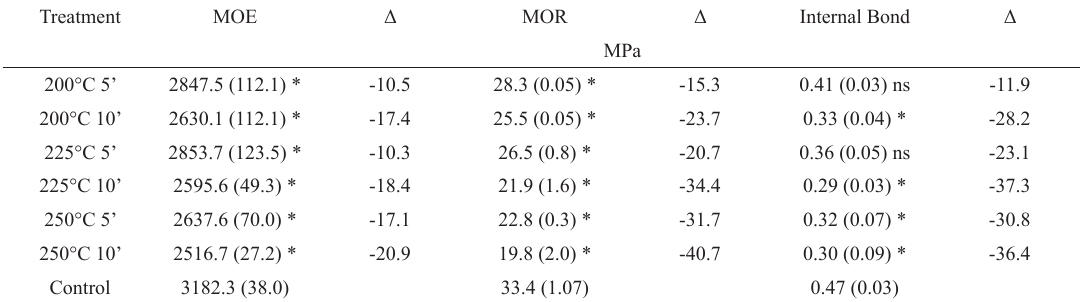
Table 7: Average values of the modulus of elasticity and modulus of rupture in bending strength and internal bond of the MDF panels.